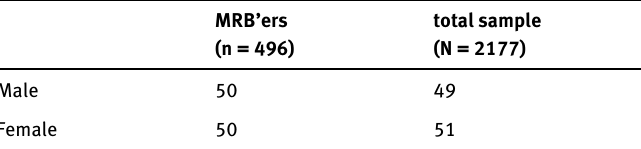
Table 13. Sex of MRB’ers (%).